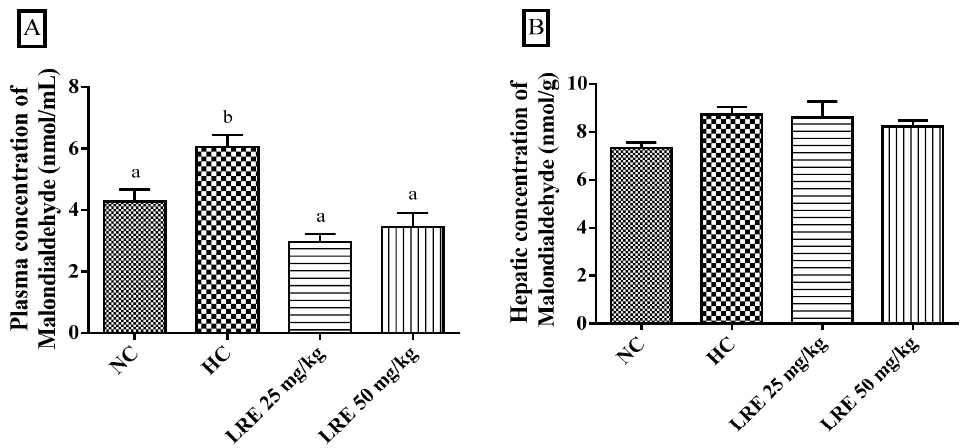
Figure 5. Concentration of malondialdehyde (MDA) in plasma ( A ) and liver ( B ) of hamsters submitted to experimentally induced dyslipidemia and treated with the lycopene-rich extract from LRE. Each column represents mean ± SEM (standard error of the mean) of 7-9 animals/group. Two mean values that are not indicated with the same letter are significantly different from each other ( p < 0.05). One-way ANOVA followed by Tukey's test.